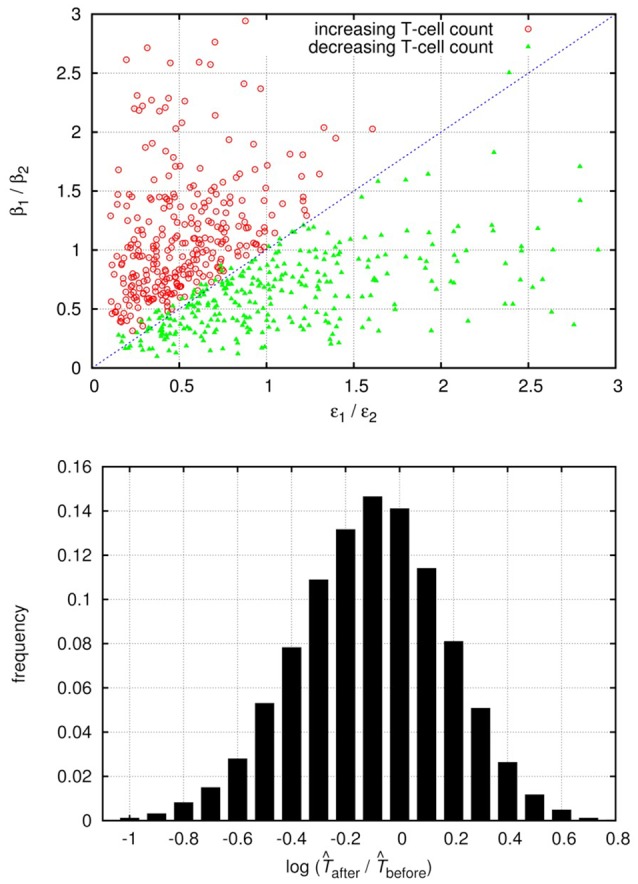
The top panel shows the change in the uninfected target cell count after superinfection as a function of the relative differences in the interference (ϵ) and infection efficiency (β) parameters of both strains; results from 600 randomly selected simulation runs of the saturating infection dynamics model (300–300 runs with both increasing and decreasing cell counts) are shown. Red circles represent runs with increasing uninfected target cell count; green triangles represent runs with decreasing cell counts. The blue dashed line of the diagonal corresponds to ϵ1ϵ2=β1β2; Equation (25) is fulfilled above the diagonal. In all runs we set σ = 10 cells per day and δT = 0.1 per day; all other parameters were drawn randomly with uniform distribution from the intervals presented in Table A5 (Appendix). The lower panel shows the histogram of the (log-transformed) ratios of the uninfected target cell counts after and before superinfection, from 20,000 simulation runs with successful superinfection.